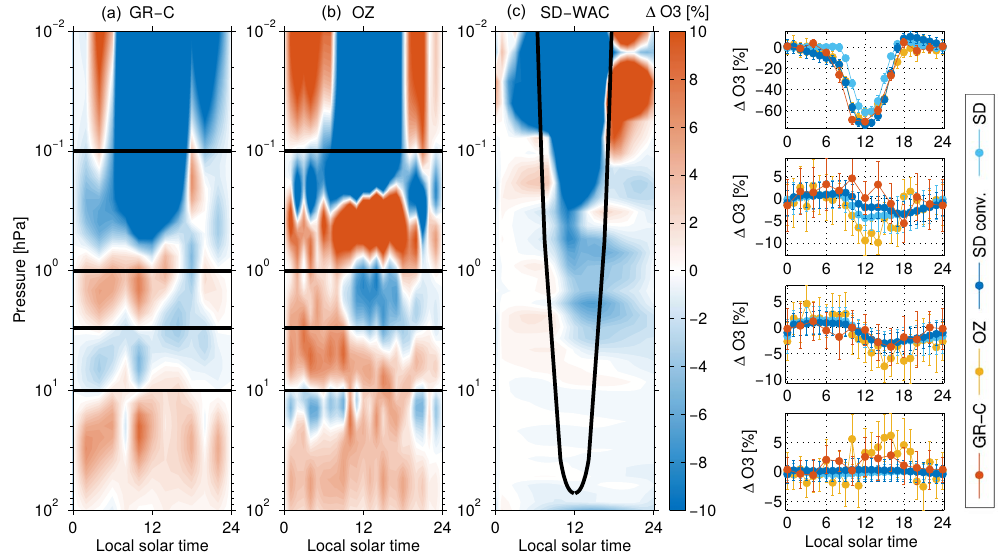
Figure 9. The diurnal cycle of ozone shown as the relative difference to the midnight value from GROMOS-C measurements (a) , OZORAM measurements (b) and SD-WACCM data (c) . The diurnal cycle is averaged over 10 days starting on 10 February 2016. The diurnal cycle is additionally shown for the convolved SD-WACCM data for 0.1, 1, 3 and 10hPa. The pressure levels are indicated by black lines in ( a and b ). The black line in (c) shows the average sunrise and sunset time.